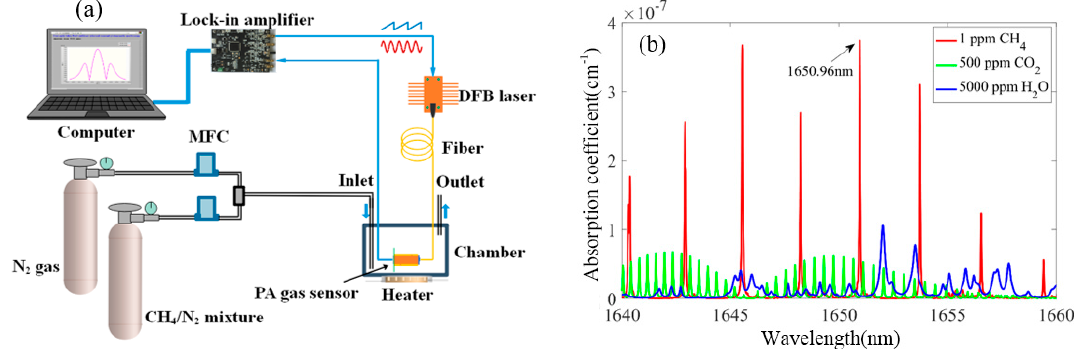
Figure 4. ( a ) Schematic structure of the test system for diffusing gas detection. MFC: mass flow controller; PA: photoacoustic; DFB: distributed feedback. ( b ) Absorption coefficients of 1 ppm CH 4 and interfering gases in the spectral range from 1640 nm to 1660 nm.